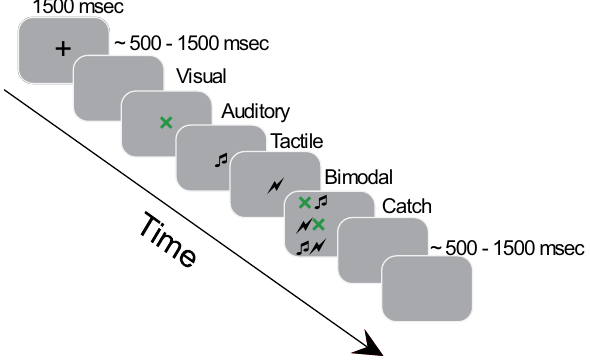
Figure 1. Timeline of the experimental trials: Each trial started with a fixation cross (1500 ms) followed after a variable blank screen (~ 500–1500 ms) by one of the following stimuli for which participant had to respond vocally: Visual (green X), Auditory (a pure tone 1000 Hz), Tactile (a suprathreshold electrical stimulus delivered on the forehead), bimodal (Audio-visual (AV) or Visuo-tactile (VT) or Audio-tactile (AT)). In the 20% of the trials no stimulation was delivered (Catch). Finally, there was a variable intertrial interval (ITI) (~ 500–1500 ms) before next trial started.